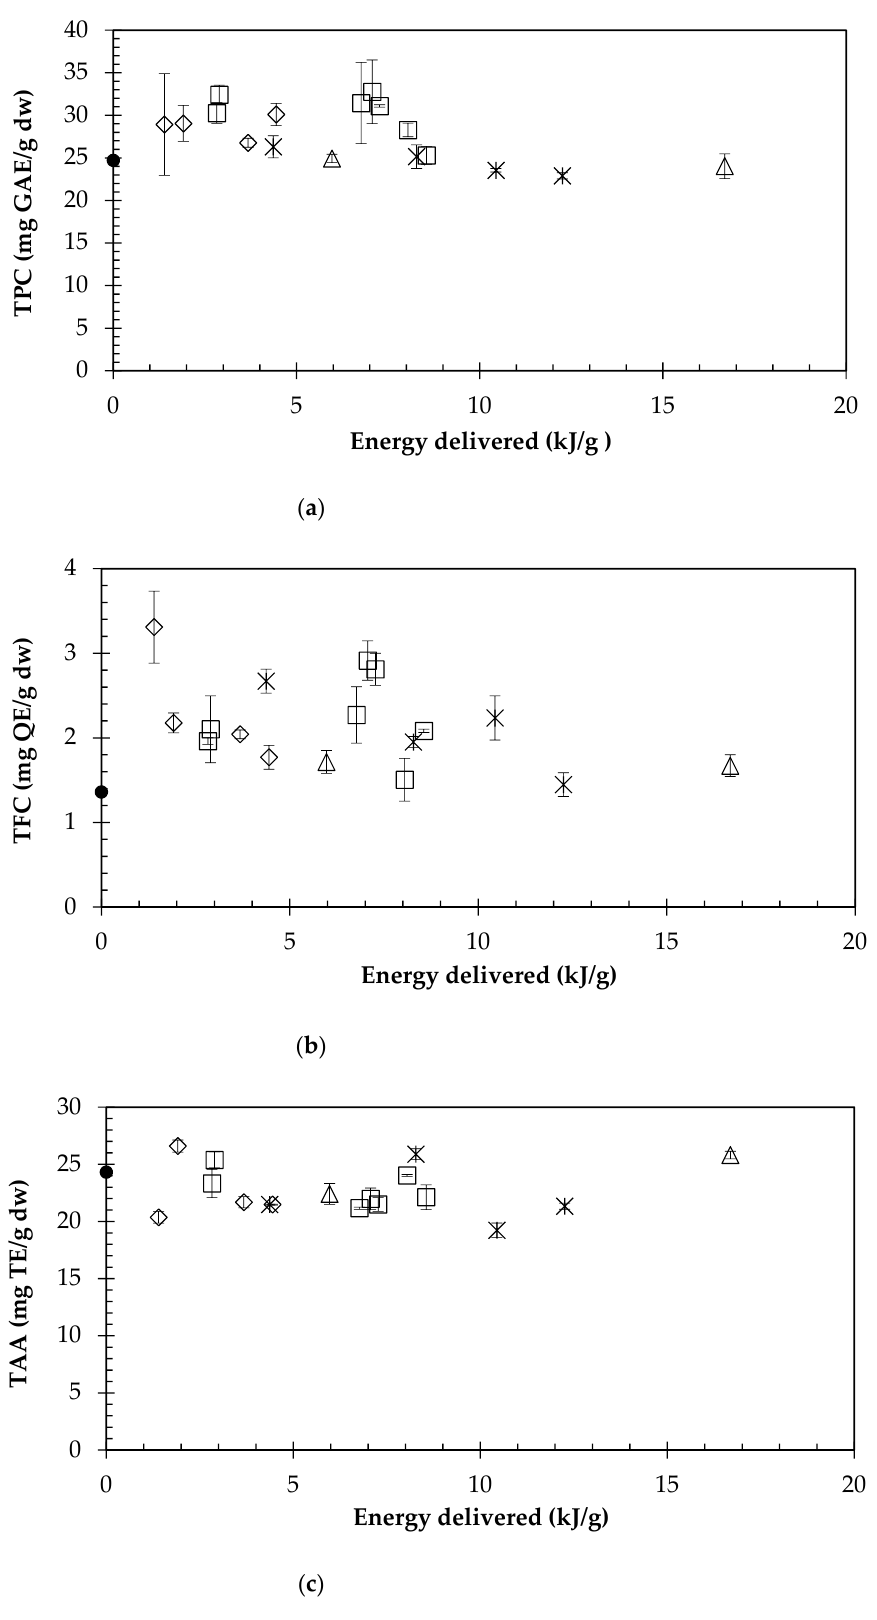
Figure 3. Effect of the specific energy delivered in the UAE extraction on TPC ( a ), TFC ( b ), and TAA ( c ), as a function of the sonication amplitude. Key: (cid:5) , 40%; (cid:3) , 60%; (cid:13) , 80%; (cid:52) , 100%; • , conventional